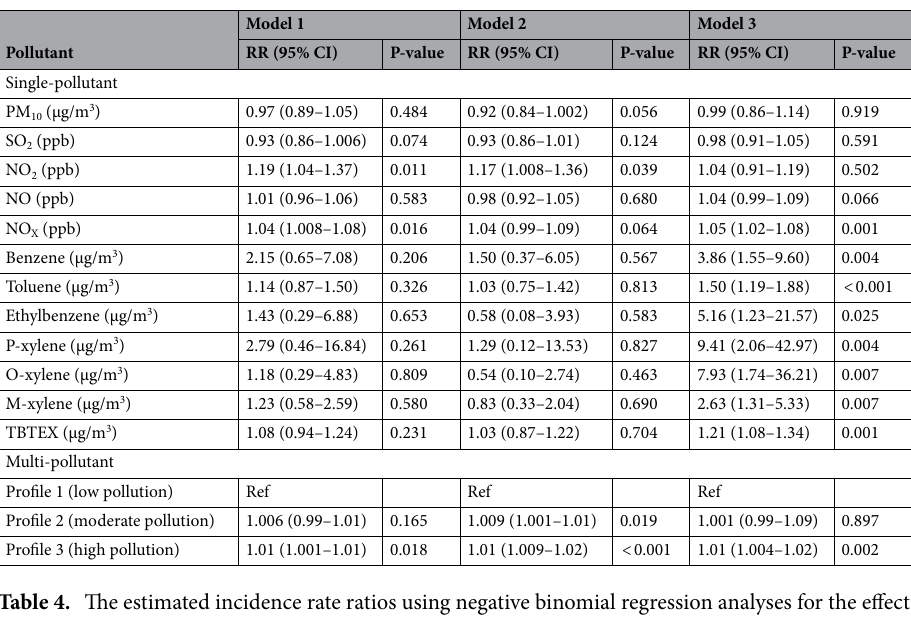
Table 4. The estimated incidence rate ratios using negative binomial regression analyses for the effect of each 10 unit increase in air pollutants on lung cancer incidence in the districts of Tehran. Model 1: Adjusted for age and gender. Model 2: Adjusted for age, gender and urban green space, per capita (m 2 per 1000 people). Model 3: Adjusted for age, gender, socioeconomic status, life expectancy and smoking prevalence. The incidence rate ratio of lung cancer is estimated for each 10 unit increase in pollutants.